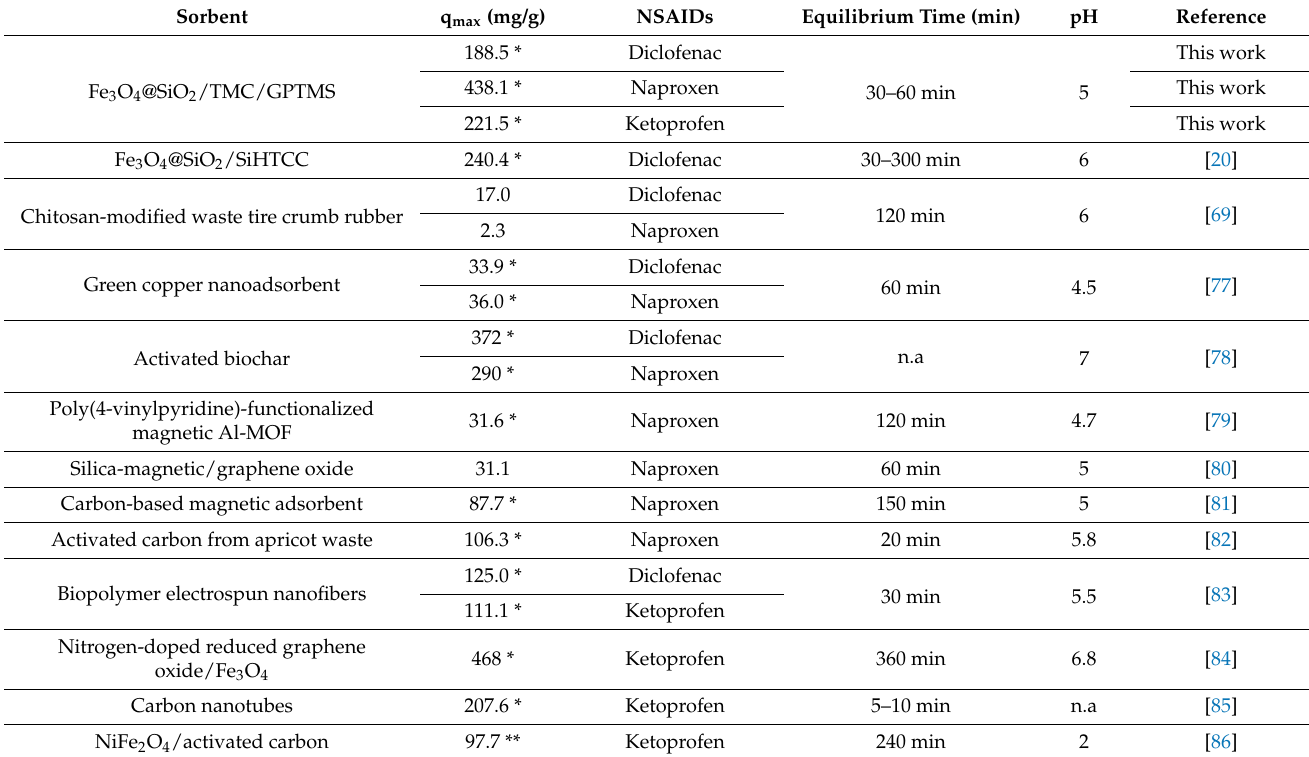
Table 2. Comparison of the maximum adsorption capacity (q max ) of several sorbents reported in the literature for the removal of diclofenac, naproxen, and ketoprofen.